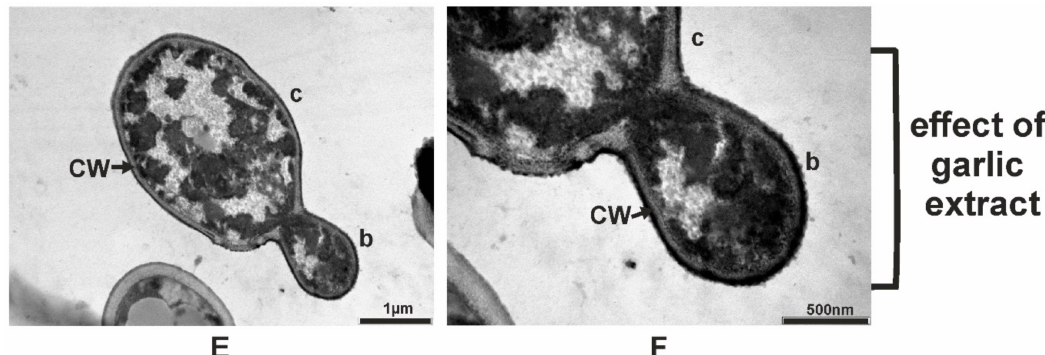
Figure 5. Transmission electron micrographs of M. guilliermondii showing ultrastructural components of control cells: longitudinal section of bud and cell ( A,B ); longitudinal section of cell (detailed) ( C ); longitudinal section of pseudohyphae (ph) and cross section of cells ( D ), and the changes produced by garlic extract in 12% minimum inhibitory concentration: longitudinal section of cell ( E ) longitudinal section of cell (detailed) ( F ). Legend: b, bud; c, cell; CW, cell wall; G, glycogen; L, lipid; M, mitochondrion; N, nucleus; P, plasmalemma; V,